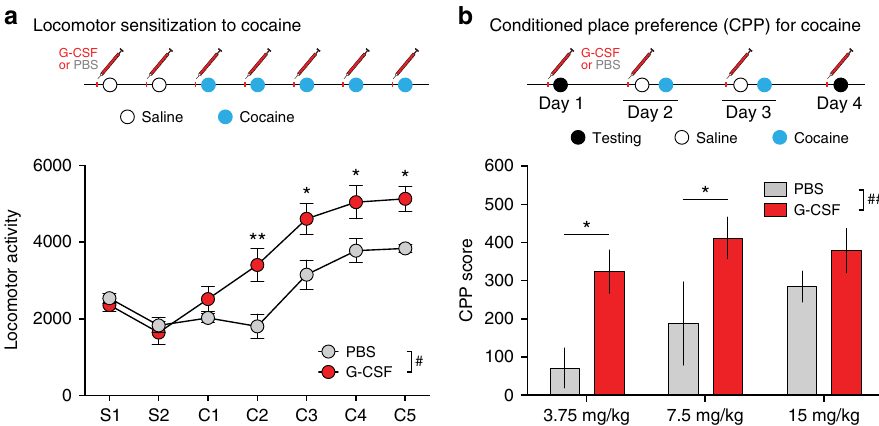
Fig. 6 G-CSF enhances cocaine-induced locomotor sensitization and CPP. ( a — top) Experimental timeline of locomotor sensitization to cocaine. Mice ( n = 4 PBS, 5 G-CSF) were i.p. injected with G-CSF (50 µ g kg − 1 ) or PBS 1 h before monitoring locomotor activity following an injection of saline or cocaine (7.5 mg kg − 1 ). ( a — bottom) Locomotor sensitization to cocaine was increased in mice pre-treated with G-CSF (repeated-measures two-way ANOVA; time: F (6,42) = 33.16, p < 0.0001; G-CSF: F (1,7) = 8.808, p = 0.021; interaction: F (6,42) = 3.942; p = 0.0032). b For cocaine conditioned place preference, mice were injected with G-CSF (50 µ g kg − 1 ) or PBS 1 h every day before testing. Two-way ANOVA testing demonstrated a main effect of G-CSF (F (1,36) = 11.76, p = 0.0015), and Holm-Sidak post-hoc testing demonstrated increased CPP in G-CSF-treated mice conditioned with 3.75 mg kg − 1 of cocaine (PBS n = 6; G-CSF: n = 9; p < 0.05 vs PBS), 7.5 mg kg − 1 (PBS: n = 6; G-CSF: n = 10; p < 0.05 vs PBS) of cocaine but not with 15 mg kg − 1 (PBS: n = 5; G-CSF: n = 6). (* p < 0.05, ** p < 0.01 for Holm-Sidak post-hoc tests; # p < 0.05, ## p < 0.01 for two-way ANOVA main